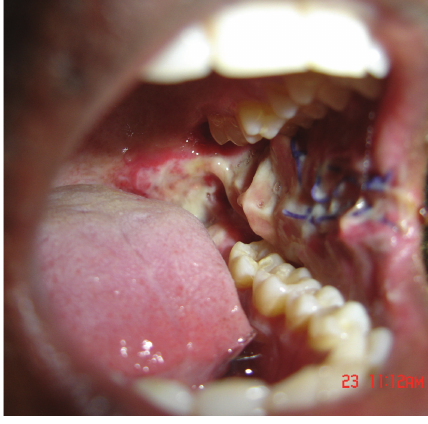
Figure 8: After 1 week. Table 2: Student’s t -test application in each variable.